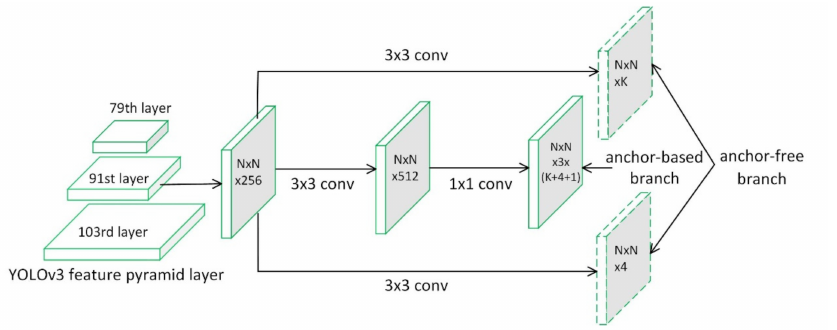
Figure 3. The improved detector network architecture. We plug the optimized FSAF module into the YOLOv3 network structure, which only adds two additional convolutional layers (dashed feature maps) per pyramid